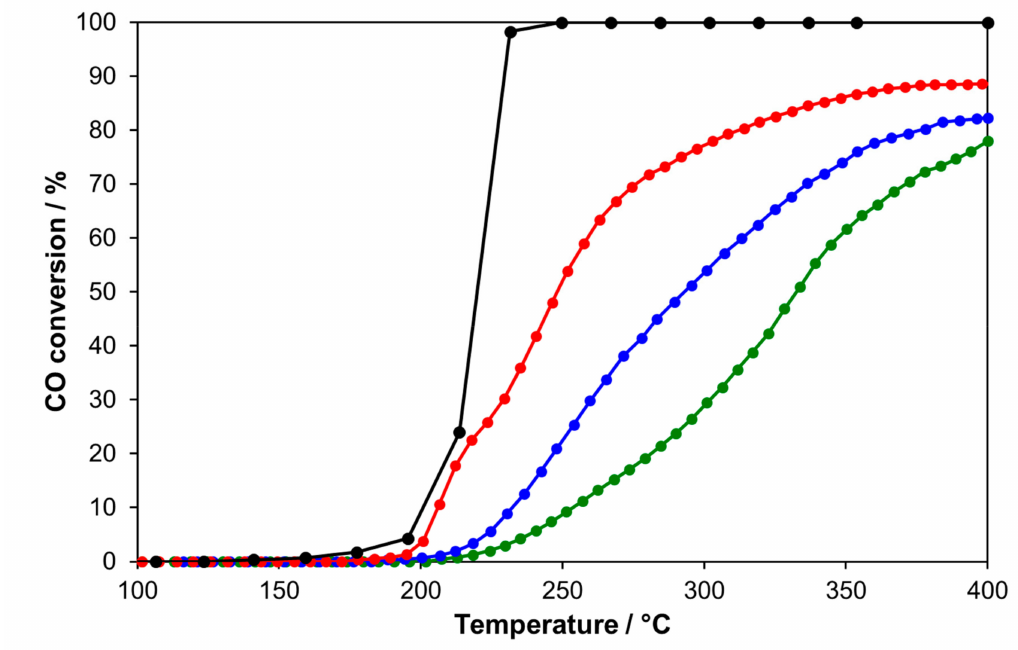
Figure 8. Light-o ff curves for CO oxidation recorded on the sputtered perovskite coatings and on Pt film. Reactive mixture: CO / O 2 = 3000 ppm / 3%. Overall flow = 3.6 L / h.